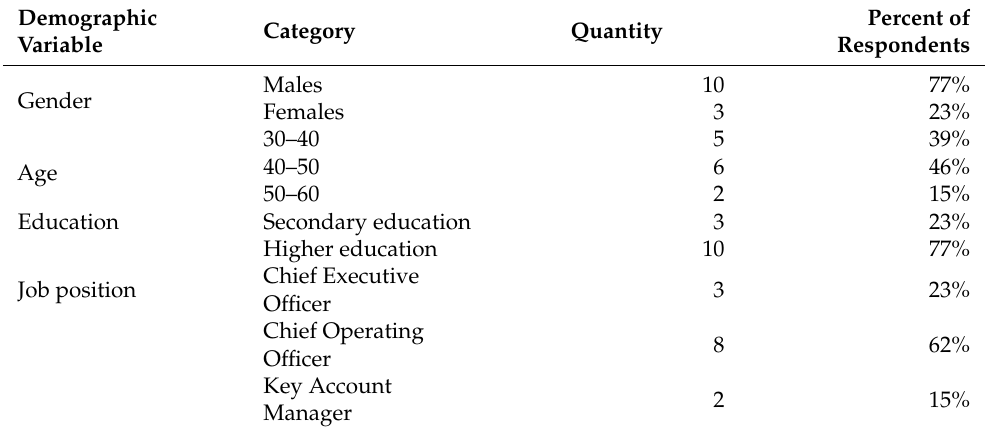
Table 2. Sample characteristics.